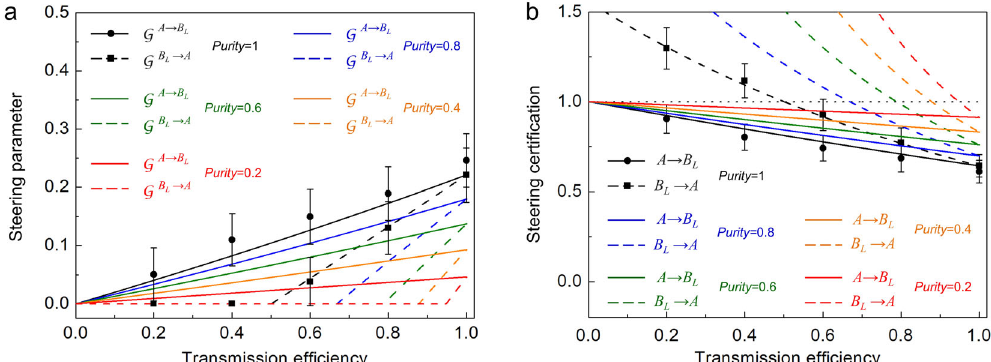
Fig. 2 The in fl uence of purity of TMSS on the Gaussian EPR steering in a lossy channel. a Steering parameter quanti fi ed by Eq. (4). b Steering certi fi cation according to Eq. (5). The region under the bound of 1 (black dotted line) indicates the existence of steerability. Theoretical results for different purities of 1, 0.8, 0.6, 0.4, and 0.2 are considered, which correspond to different δ of 0, 0.5, 1.33, 2.99, and 7.97, respectively. The experimental data (black circles and squares) for the pure TMSS agree well with the theoretical prediction (black solid and dash curves). Error bars of experimental data represent ±1 standard